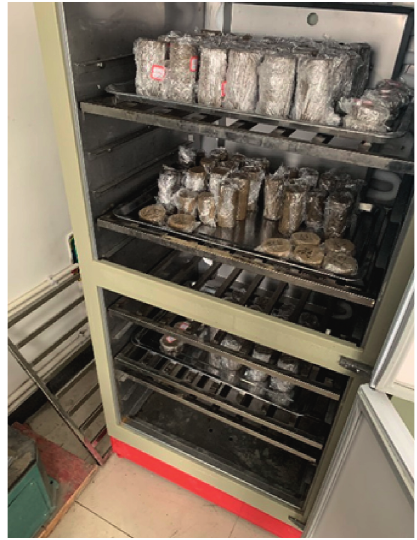
Figure 6: Standard